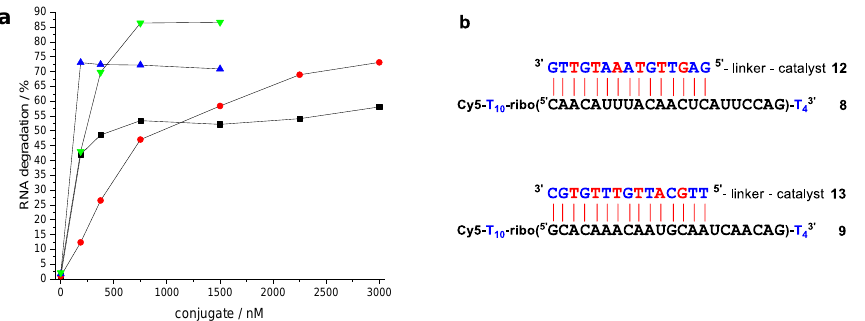
Figure 2. ( a ) Percentage of RNA cleavage after constant time as a function of conjugate concentration (150 nM of RNAs 8 or 9 , 50 mM Tris buffer (pH 8.0), 37 °C, 20 h). Red circles: RNA 8 and conjugate 10 . Green triangles: RNA 8 and DNA/LNA-mixmer conjugate 12 . Black squares: RNA 9 and DNA conjugate 11 . Blue triangles: RNA 9 and mixmer conjugate 13 . Data points are connected by lines for the sake of clarity. ( b ) Structures of mixmer conjugates 12 and 13 . DNA, LNA, and RNA nucleotides are shown in blue, red, and black letters, respectively.